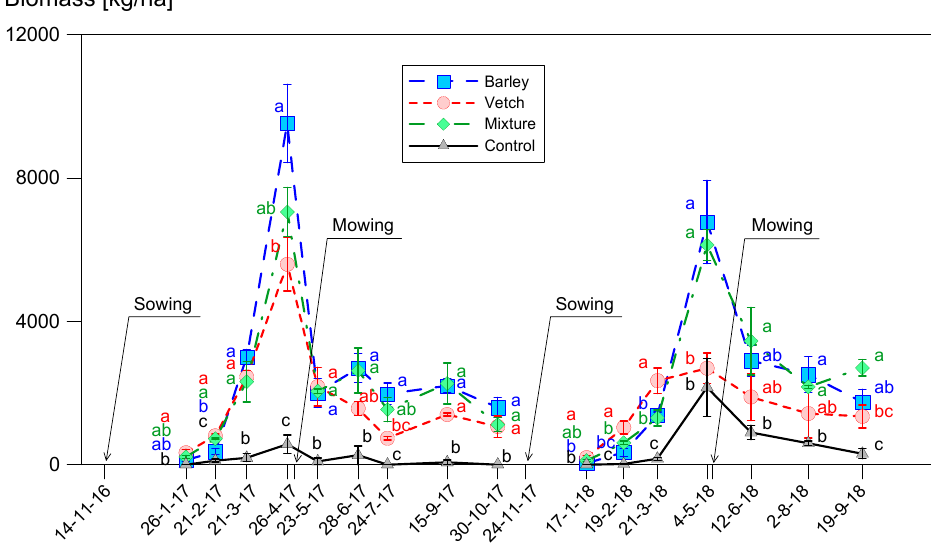
Figure 3. Biomass production of plant covers for each treatment during the two-monitoring seasons.